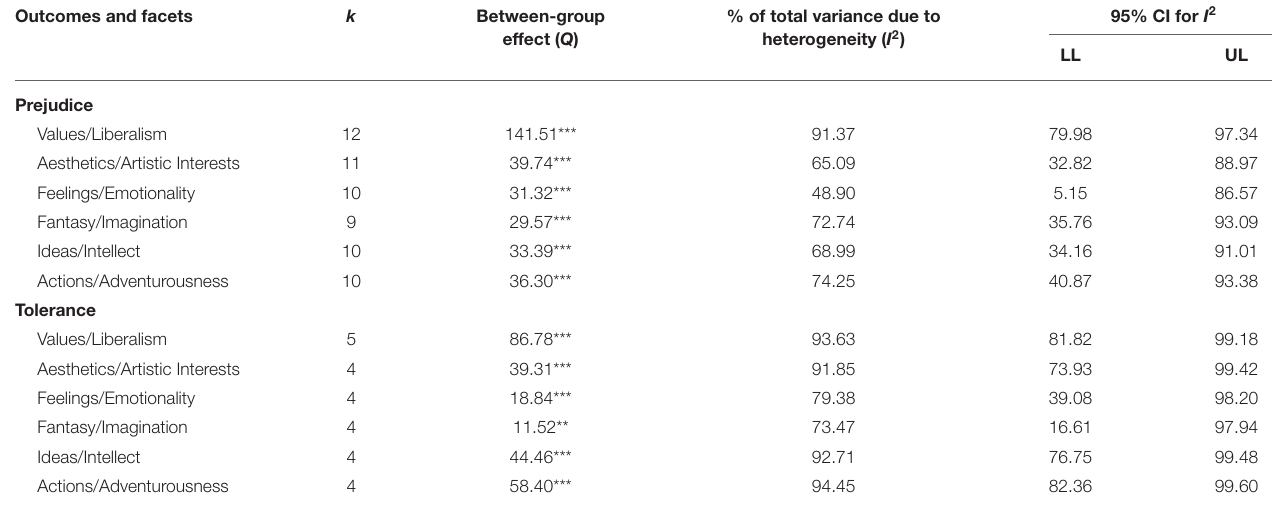
TABLE 4 | Heterogeneity statistics for the associations between the facets of openness and the two outcome variables (prejudice and tolerance). Outcomes and facets